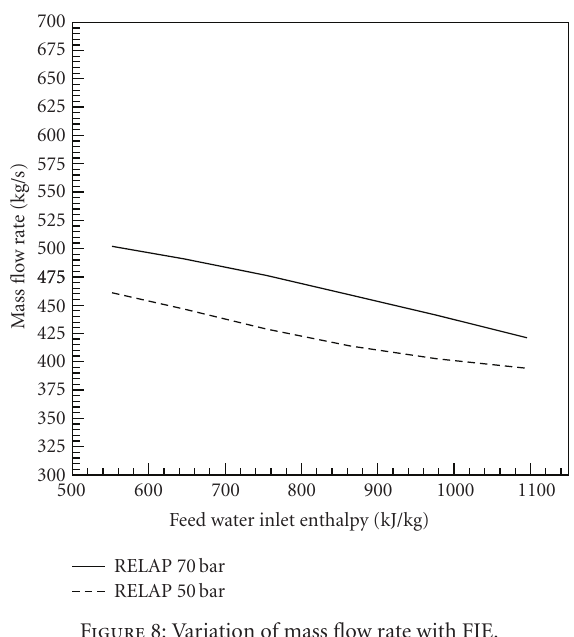
Figure 8: Variation of mass flow rate with FIE.